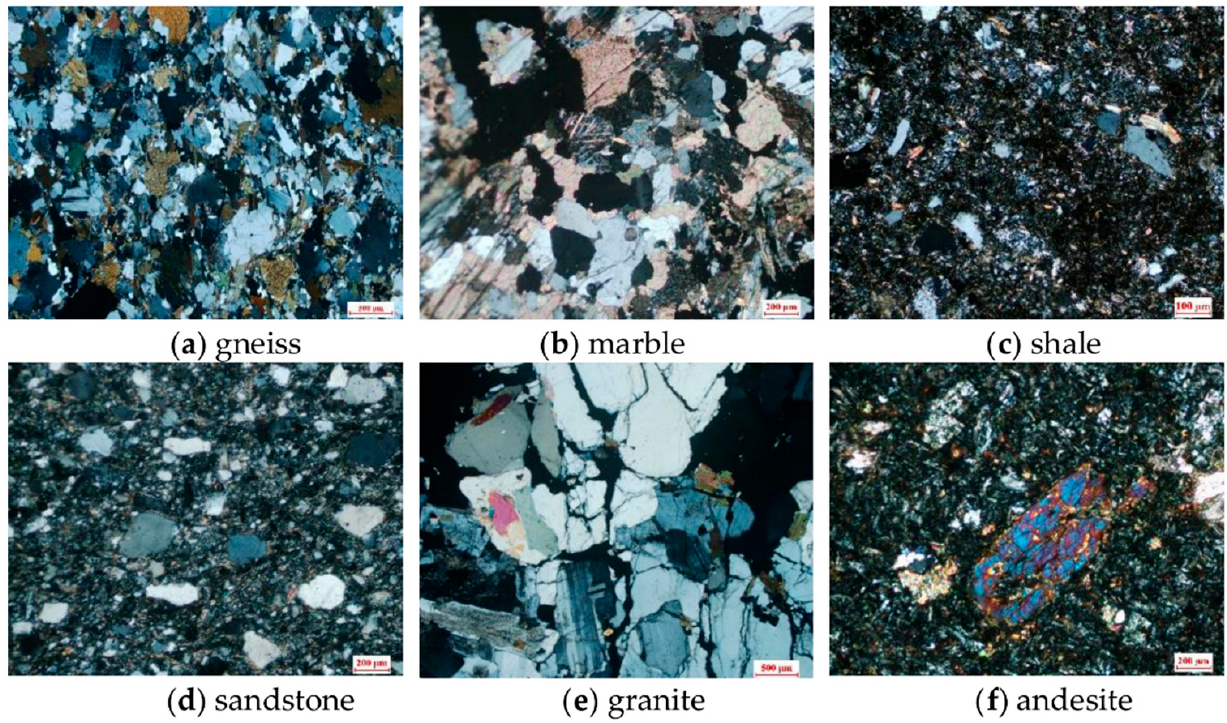
Figure 1. Three types of microscopic thin-section images: ( a , b ) metamorphic rocks; ( c , d ) sedimentary rocks; ( e , f ) volcanic rocks. Table 1. Detailed descriptions of the dataset.